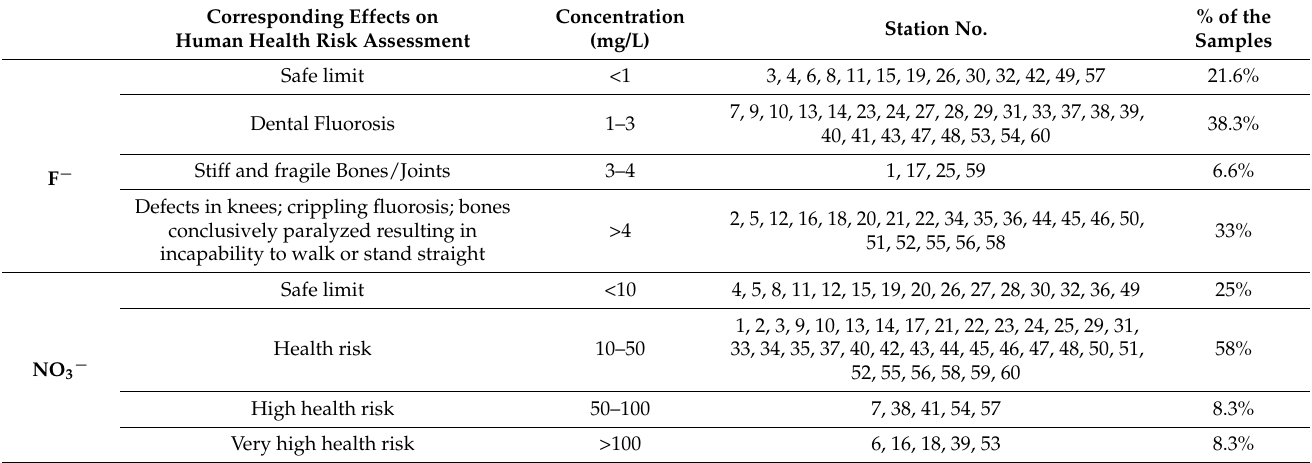
Table 3. Classification of water resources based on F − and NO 3 − (mg/L)